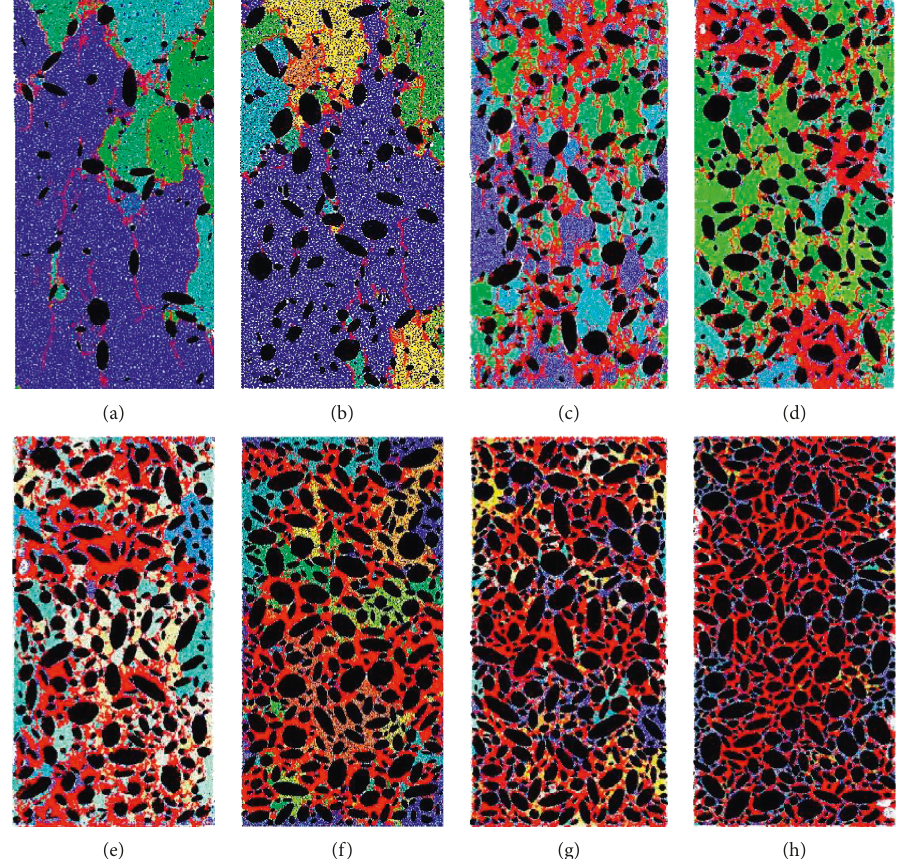
Figure 9: Distributions of bond failure zones under different rock block proportions. (a) 10%. (b) 20%. (c) 30%. (d) 40%. (e) 50%. (f) 60%. (g) 70%. (h) 80%.